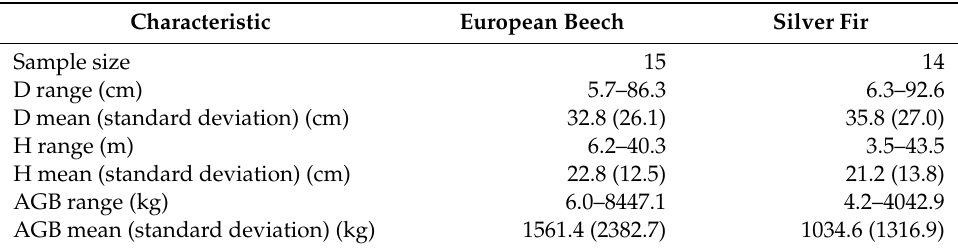
Table 1. The characteristics of site-specific sample trees (full sample). Note: D is the diameter at breast height; H is the tree height; AGB is the aboveground biomass.